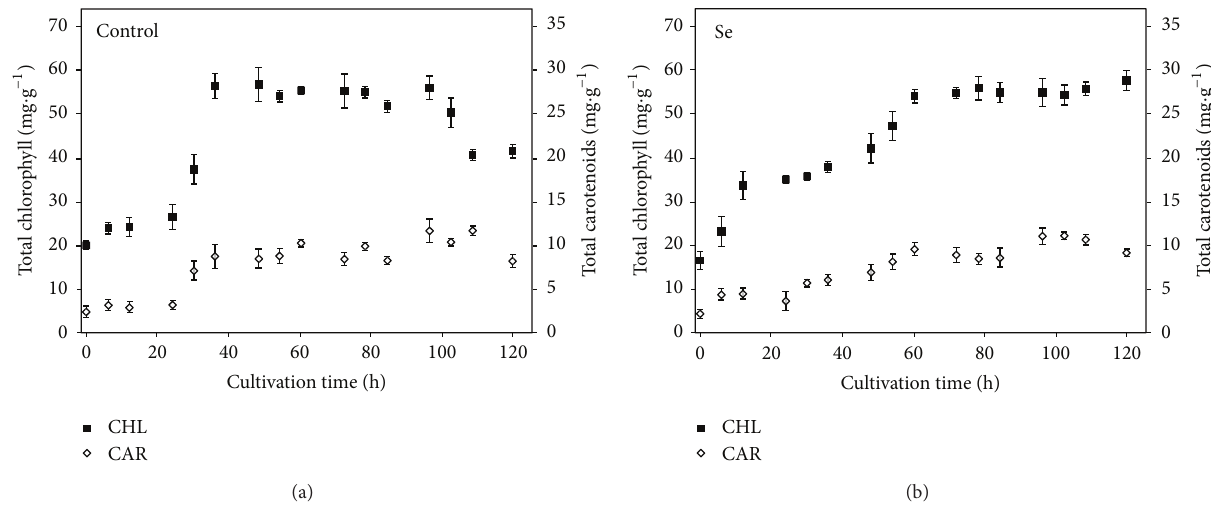
Figure 5: Total chlorophyll (mg ⋅ g −1 ) and total carotenoids (mg ⋅ g −1 ) content per biomass weight as a function of cultivation time for (a) control (no selenate) and (b) culture with 40mg ⋅ L −1 of selenate in culture medium. Data are given as mean values ± S.D. of the means.